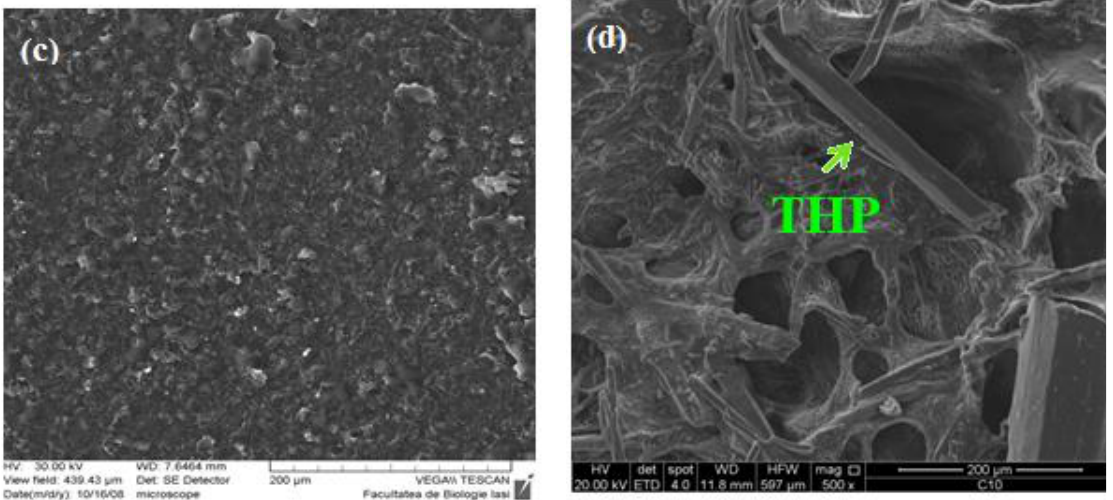
Figure 3. Scanning electron microscope (SEM) images of IPC 72/28 unloaded ( a ) and loaded with theophylline ( b ) and grafted copolymer AgA- g -PNIPAAm unloaded ( c ) and loaded with theophylline ( d ).